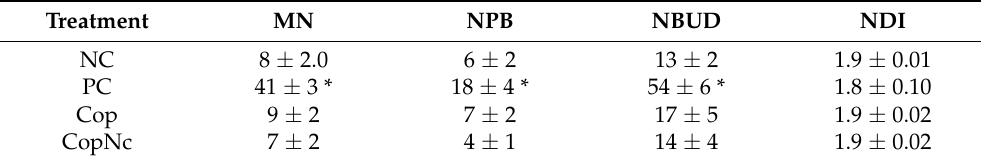
Table 3. Effect of the exposure of alveolar epithelial lung A549 cells to Cop and CopNc (200 µ g · mL − 1 based on the theoretical amount of Cop) on the frequencies of DNA alterations per 1000 binucleated cells. Treatment MN NPB NBUD NDI